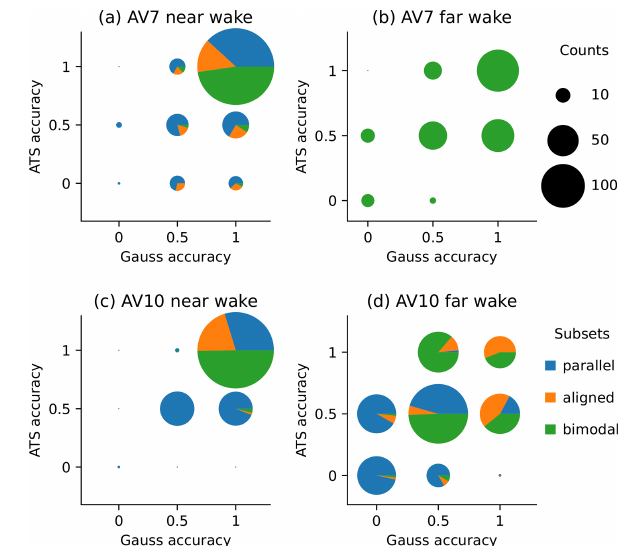
Figure 22. Overview of the Gaussian and ATS method performance on the wake detection and characterization.